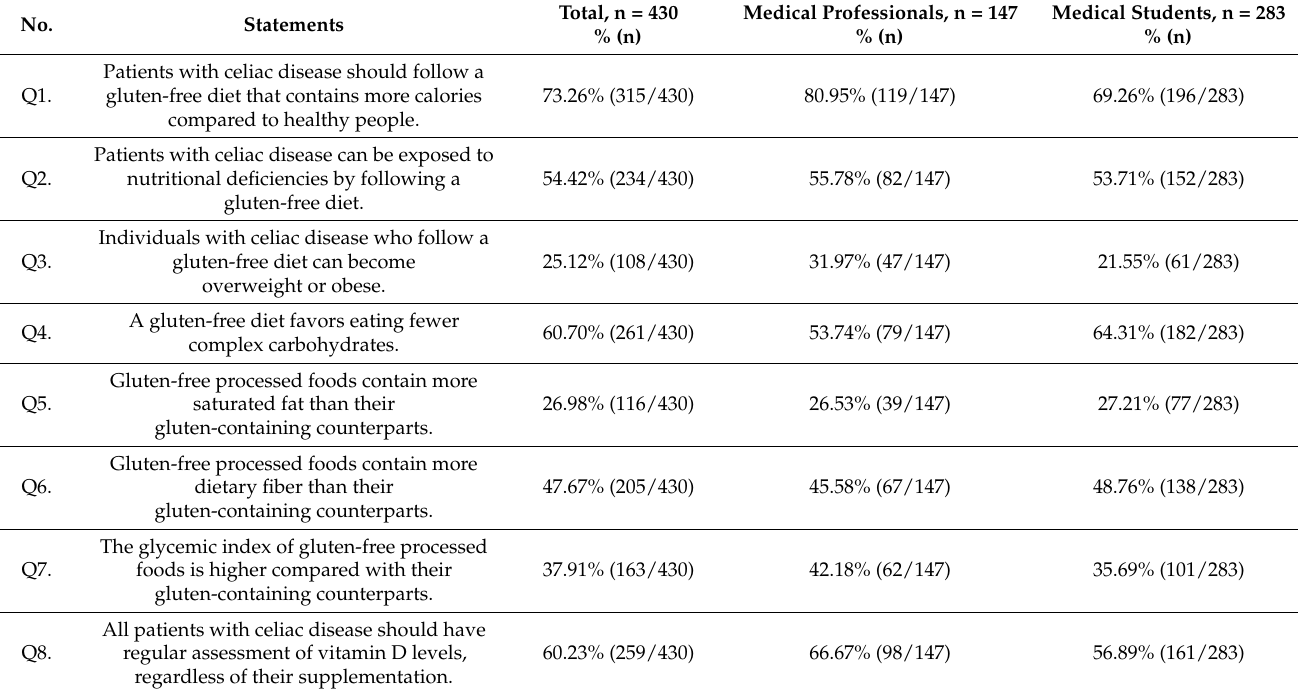
Table 2. Distribution of correct